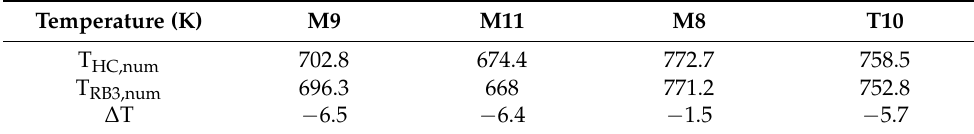
Table 9. Test 3: Numerical temperature of honeycomb and rhomboidal cells. Temperature (K)